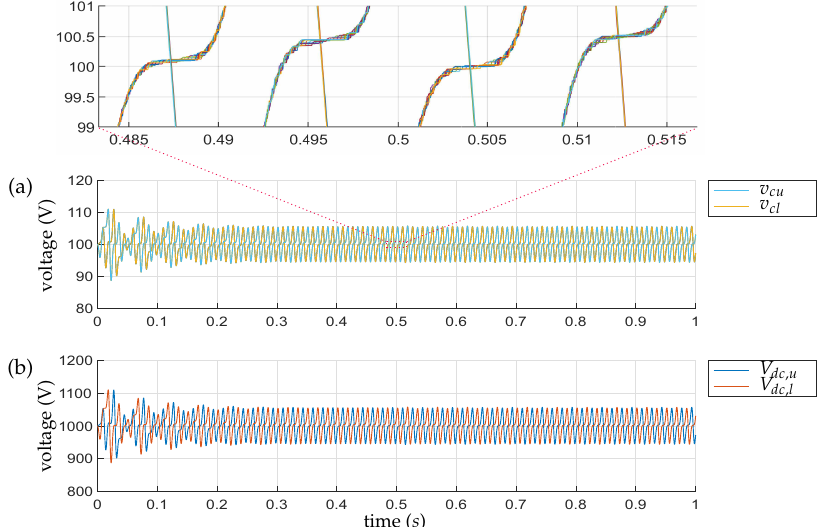
Figure 15. The submodule capacitor voltages, whit SAM and improved SAM techniques. Figure 15. ( a ) The submodule capacitor voltages, whit SAM and improved SAM techniques; ( b ) The leg